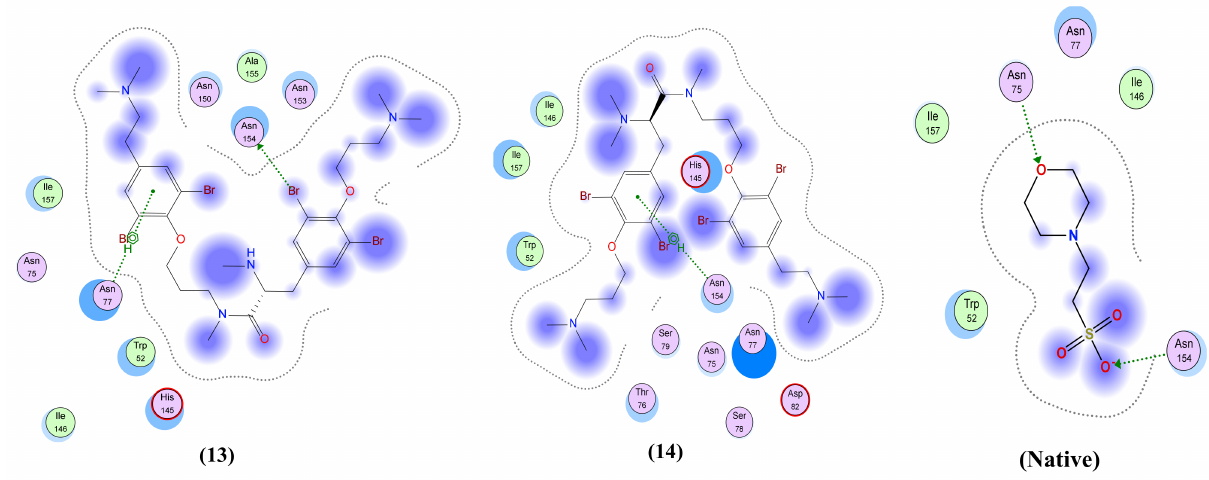
Figure 6. The 2D interactions of the 14 library compounds plus the native ligand with nucleocapsid phosphoprotein (PDB ID: